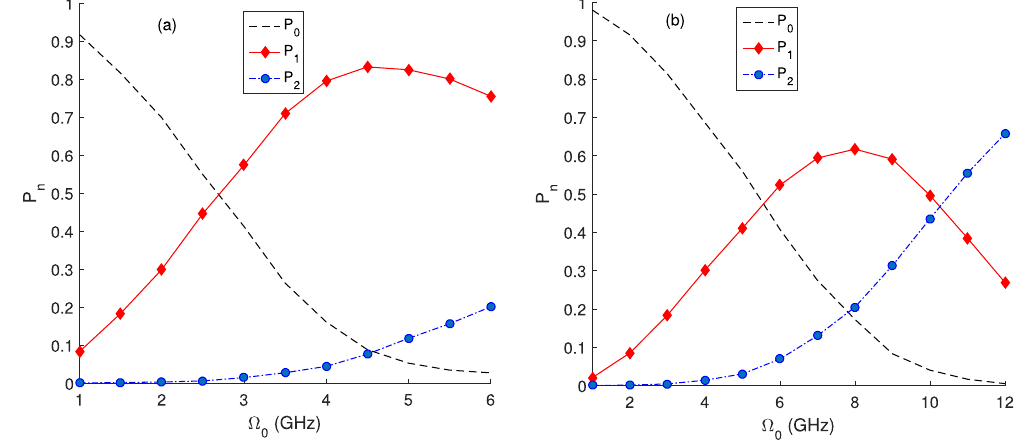
Figure 2. P n verses Ω 0 : ( a ) when χ = 15 GHz, τ = 0.2 ns, κ = 5 GHz; ( b ) when χ = 15 GHz, τ = 0.1 ns, κ = 10